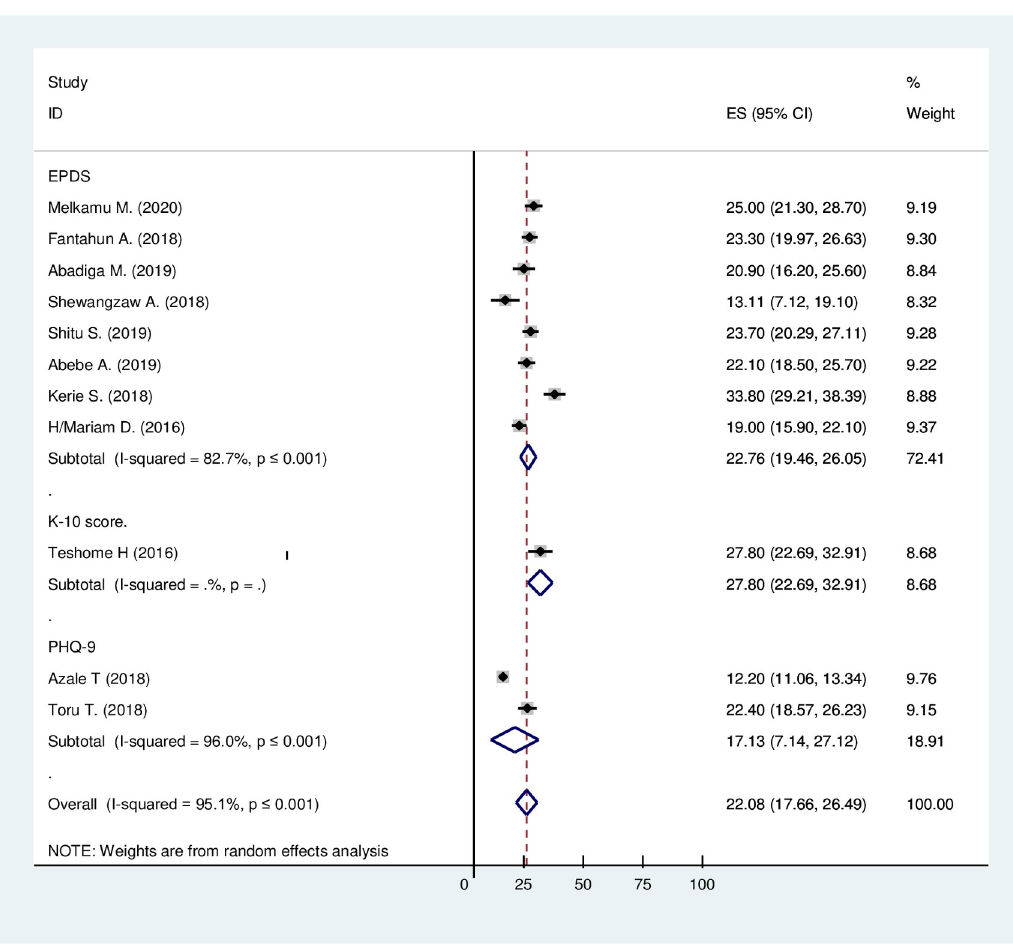
Fig 5. Forest plot presenting of subgroup analysis of the pooled estimated prevalence of post-partum depression based on tools in Ethiopia, 2020.